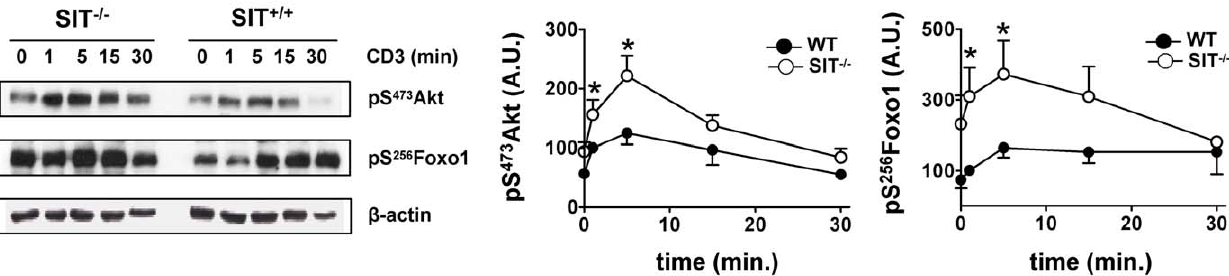
Figure 1. Enhanced phosphorylation of Akt and Foxo1 in SIT 2 / 2 CD4 + T cells. Purified splenic CD4 + T cells from 3–4 month-old SIT 2 / 2 or WT mice were stimulated with non-crosslinked CD3 (clone 145-2C11) mAb for the indicated times. Samples were analyzed by Western blotting using the indicated Abs. The phosphorylated Akt and Foxo1 bands were quantified using the ImageQuant software and values were normalized to the corresponding b -actin signal. Graphs show the phosphorylation levels of Akt and Foxo1 shown as of arbitrary units 6 SEM of at least 3 independent